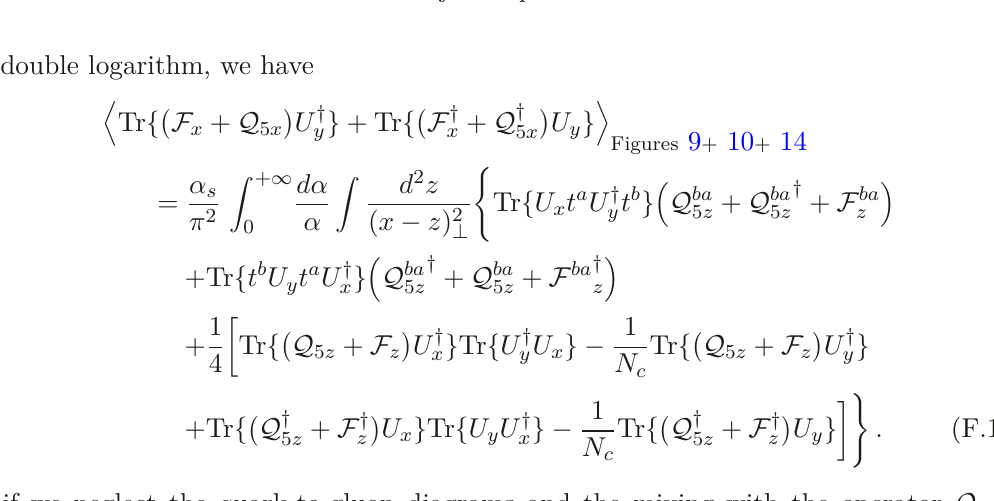
Figure 15 . One loop correction diagrams to the operator Q αβ to-gluon propagator. Single dotted lines are Wilson-line in the fundamental representation, while double dotted lines are Wilson-line in the adjoint